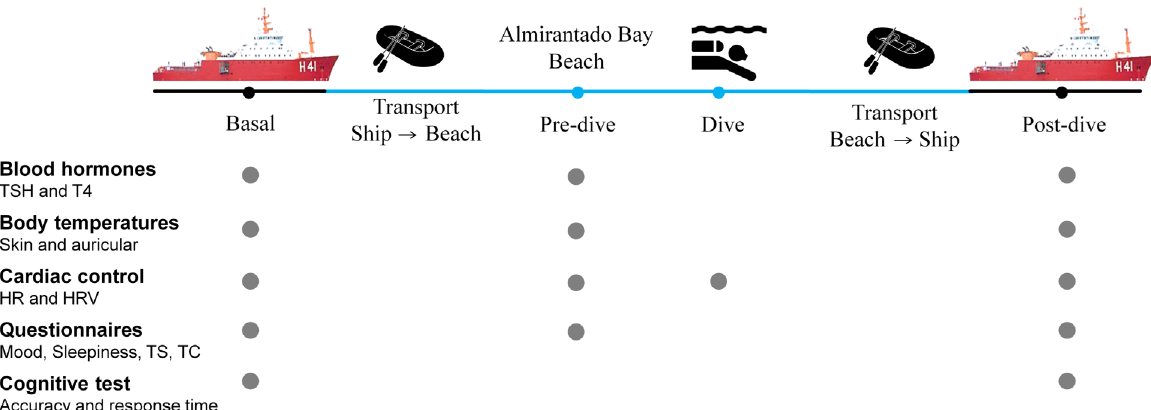
Figure 2. Timeline of data collection . Data were collected at the following moments: ‘basal’, on the ship (at 9:00 am), ‘pre-dive, in the Admiralty Bay Beach (at 11:30 am), ‘dive’, during immersion in open waters (from 11:45 am to 11:51 am), and ‘post-dive, on the ship (at noon). The displacements between the ship and the dive site were carried out by boat. The gray circles represent the measurements made at each time point. Abbreviations: thyroid-stimulating hormone (TSH); thyroxine (T4); heart rate variability (HRV); heart rate (HR); thermal sensation (TS); thermal comfort